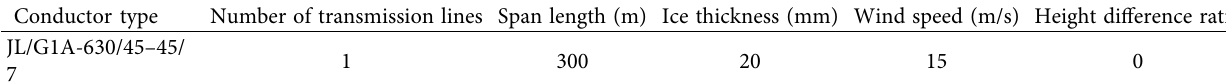
Figure 4: Single-span transmission line. Table 6: Standard working conditions of conductor icing.